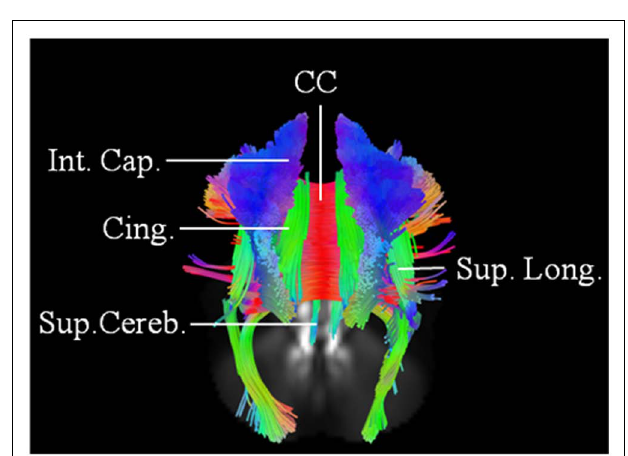
fibers coursing toward the brainstem in the posterior limb of the internal capsule (Int. Cap.); cinguli (Cing.); superior longitudinal (Sup. Long.); and inferior occipito-frontal fasciculi. (D) Cortical end points for the second scan display predominant involvement of fibers originating from the precentral gyrus (Precent. gyr.) and frontal areas.